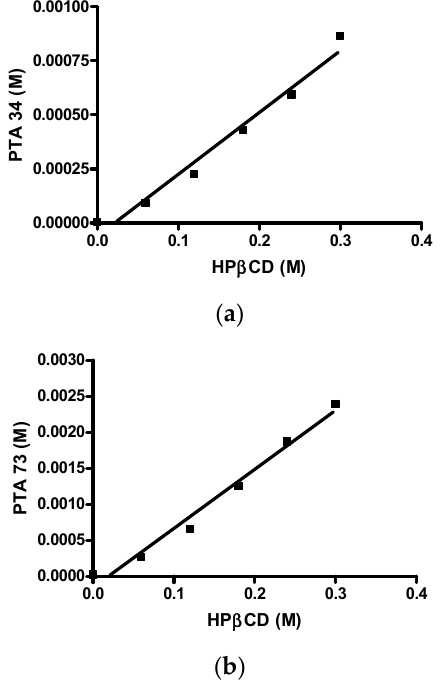
Figure 2. Phase solubility diagrams. ( a ) PTA34/HP- β -CD; ( b ) PTA73/HP- β -CD. Table 1. PTA34 and PTA73 Water Solubility Values in Presence of HP- β -CD.